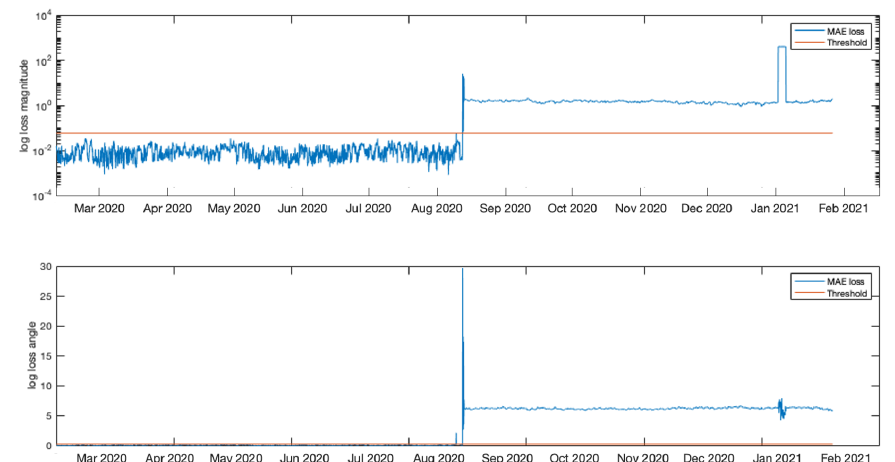
Figure 6. MAE loss and the derived threshold on the data after complete training.